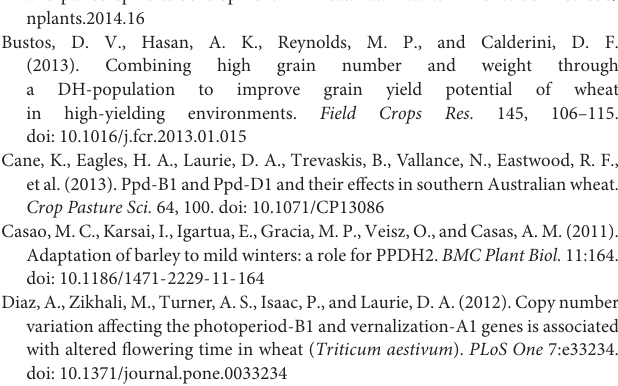
TABLE S1 | Pedigrees and corresponding allelic combinations for Ppd-A1 and Ppd-B1 loci present in the genotypes used in the study. TABLE S2 | Environmental variables during the field experiments. TABLE S3 | Percentage of the total sum of squares for pre-flowering phases, corresponding to the different sources of variation in the ANOVA model obtained from the evaluation of 23 durum wheat genotypes grown in three sites of contrasting latitude during three years (2010, 2011, and 2012). TABLE S4 | Percentage of the genotype sums of squares from the ANOVA for pre-flowering phase duration, partitioned in differences between allelic variants at Ppd-A1 and Ppd-B1 genes and the differences within genotypes carrying a given allele. Data from 3 sites and 3 years. TABLE S5 | Mean values across 3 sites and 3 years for pre-flowering phenological phases for each Ppd-A1 and Ppd-B1 allele, expressed as growing degree-days (GDD). The number of genotypes carrying each allele is shown in Table 2 . Different letters between alleles at each gene indicate differences according to LSD test at P <